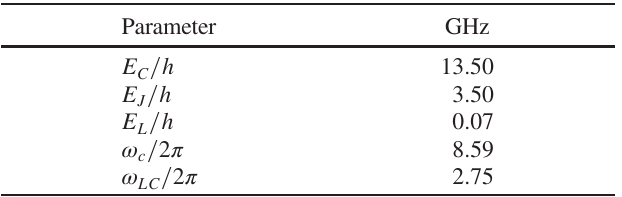
TABLE I. Mapping of the parameters and variables used in the TABLE II. Design parameters for the circuit in Fig. 10. These jargon of a crystal electron and cQED, such that the Hamiltonians parameters are achievable in state-of-the-art superconducting in Eqs. (28) and (46) coincide. Note that the cyclotron frequency circuits. The value of the inductive energy is taken from G=C . in terms of circuit parameters is ω Ref. [100]. The charging energy and the inductive energy c ¼ correspond to a capacitance C ¼ 1 . 4 fF and an inductance L ¼ 2 . 3 μ H,